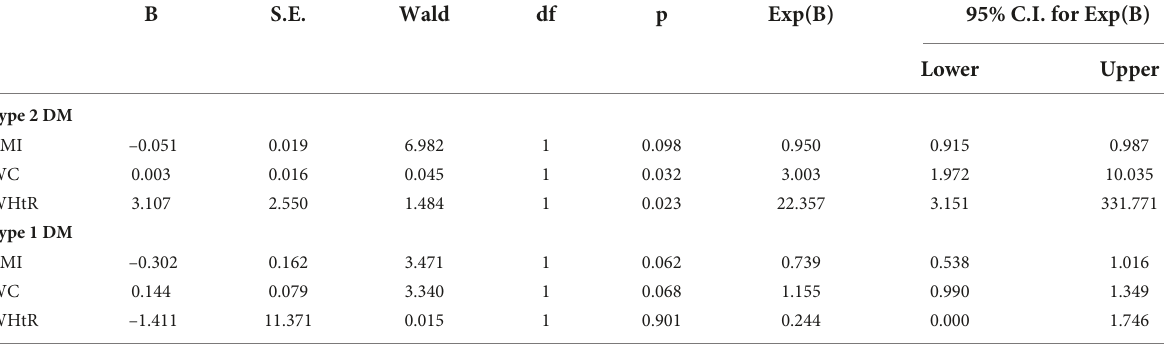
TABLE 3 Logistic regression showing odds ratio of obesity indices for peripheral neuropathy in persons with type 1 and type 2 DM.